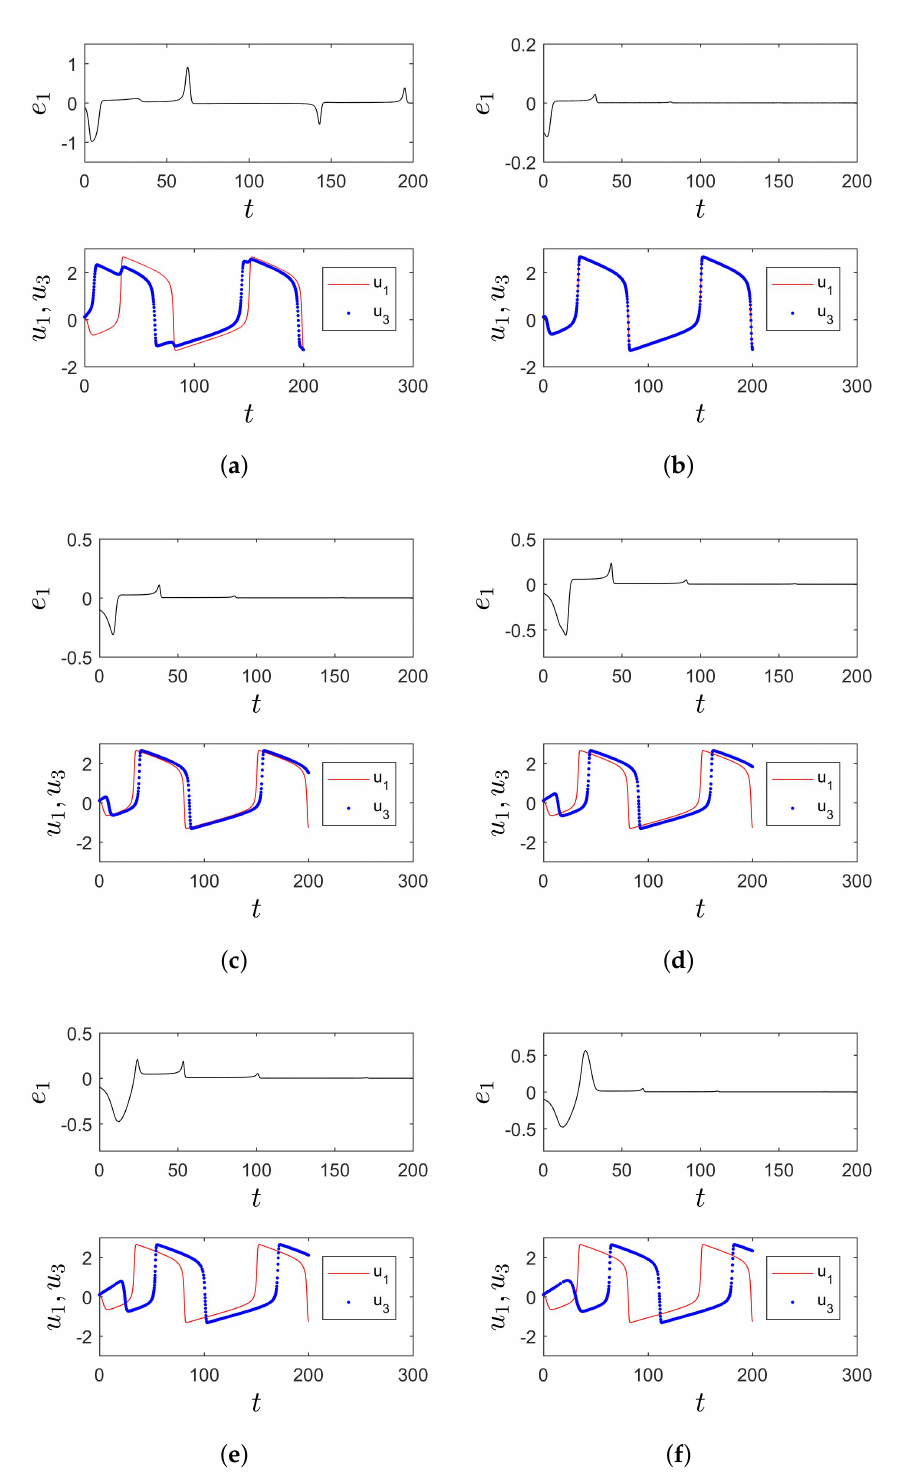
Figure 1. Synchronization errors and functional relation between u 1 and u 3 in System (3) with H ( u 1 ) = u 1 ( t − τ ) and ( a ) k = − 0.19, τ = 0, ( b ) k = − 0.7, τ = 0, ( c ) k = − 0.7, τ = 5, ( d ) k = − 0.7, τ = 10, ( e ) k = − 0.7, τ = 20, and ( f ) k = − 0.7, τ =